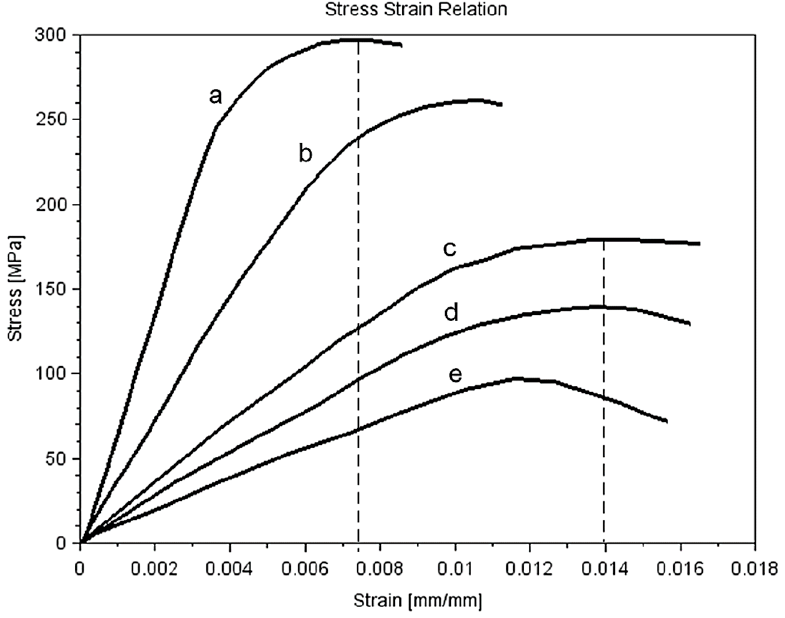
Figure 2. Relationship Stress-Strain for different strain ratio [26] ( a ) 1500 1/s, ( b ) 300 1/s, ( c ) 1 1/s, ( d ) 0.01 1/s, ( e ) 0.001 1/s. (d) 0.01 1/s, (e) 0.001